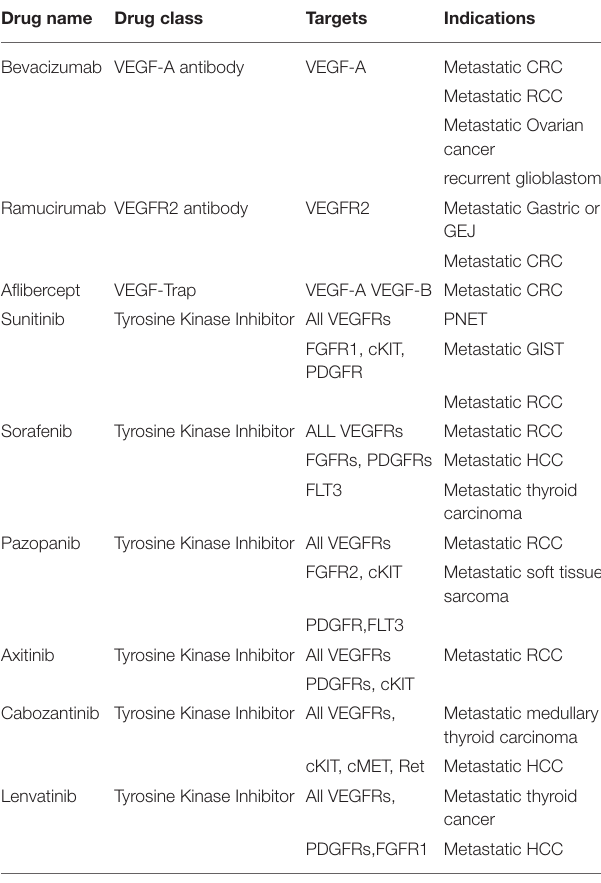
TABLE 2 | List of indirect angiogenesis